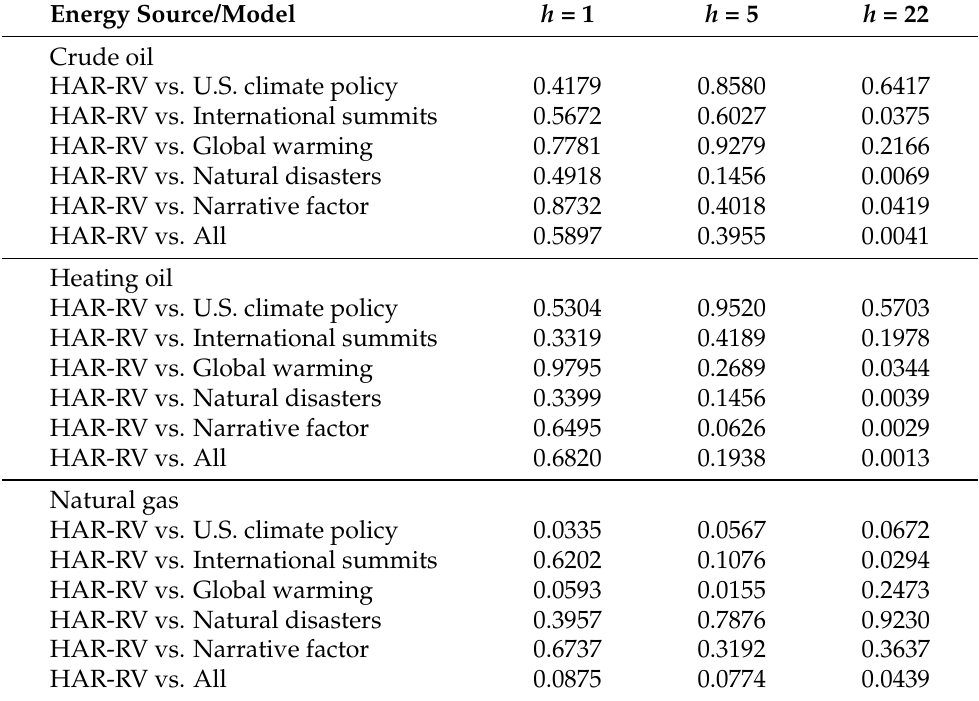
Table 4. Test results for a shorter sample period. Results ( p -values; robust heteroskedasticity and autocorrelation consistent standard errors) of the Clark–West tests for an equal mean-squared prediction error are based on robust standard errors. The classic HAR-RV model is the benchmark model, and the model extended to include climate-risk factors is the rival model. The alternative hypothesis is that the rival model has a smaller MSPE than the benchmark model. The parameter h denotes the forecast horizon (in days). The models are estimated using a rolling-estimation window of length 250 observations. The first 1500 forecasts are